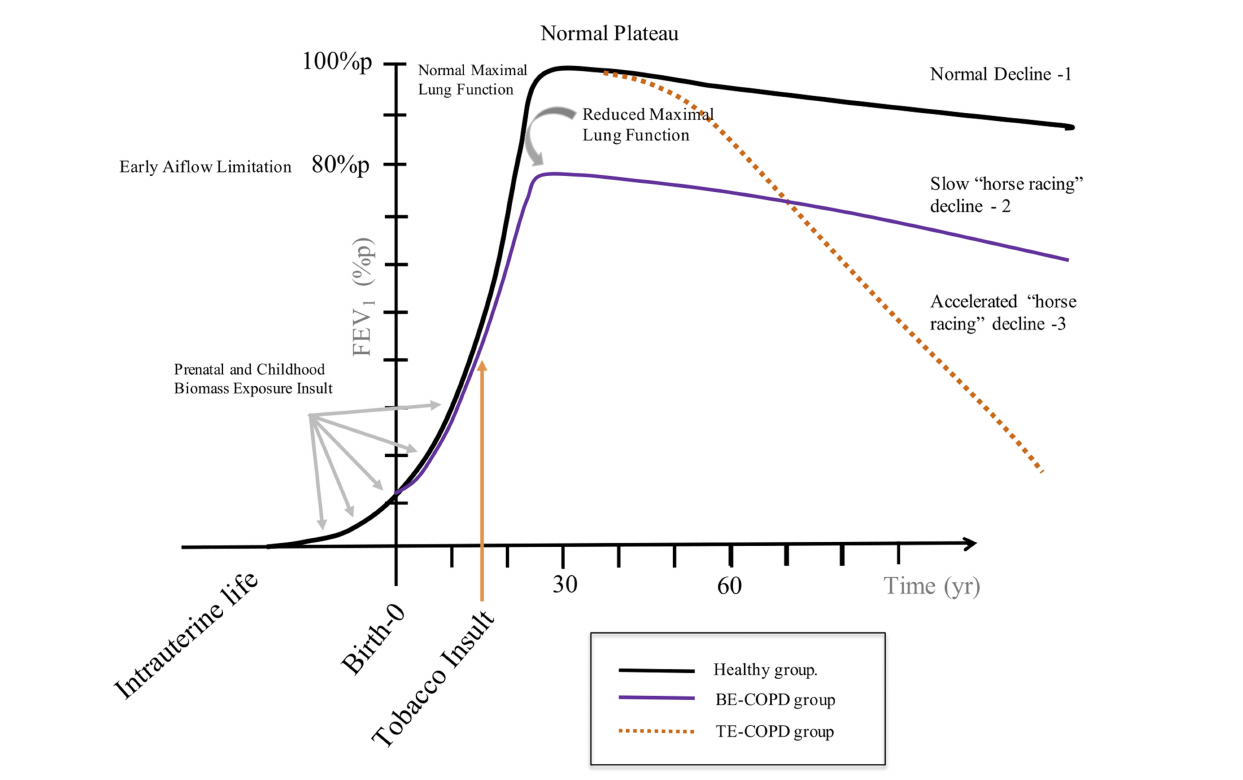
FIGURE 1 | This figure exposes three different trajectories of lung function. Trajectory 1 ( ) shows a group of healthy individuals with no history of insults during childhood nor through all of them life, who had a normal maximal lung function age of 25 and had a normal decline in lung function. Trajectory 2 ( ) shows a group of women who had history of exposure to biomass smoke both in the prenatal and childhood phases, with adverse event during childhood, who had: (a) a reduced maximal lung function (around 80% of predicted) and showing a slow decline after the plateau but with similar trajectory as a normal group. Trajectory 3 ( ) shows the cohort of individual who became smokers at the adolescence, they shape a similar curve as healthy individuals reaching a normal maximal lung function. However, after plateau an accelerated decline is